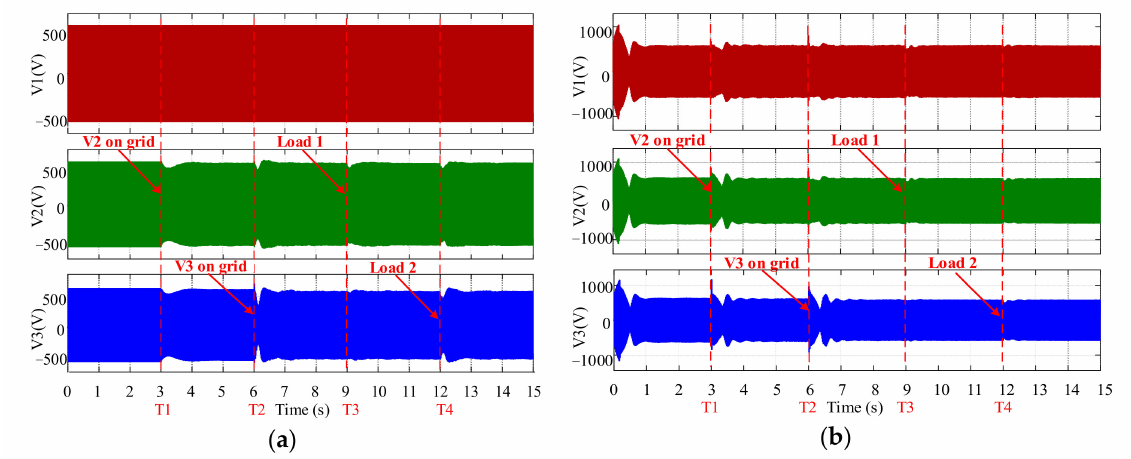
Figure 5. Three substation output voltages of different control strategies under a no-load condition: ( a ) the traditional control strategy; ( b ) the proposed